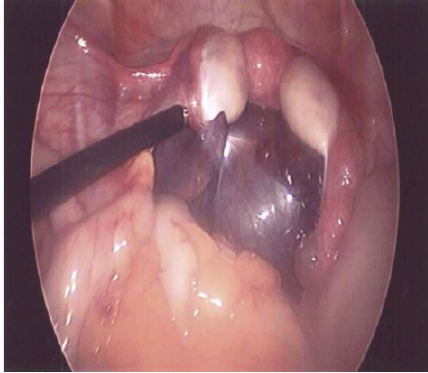
Figure 1: Laparoscopic view of torsed left fallopian tube.